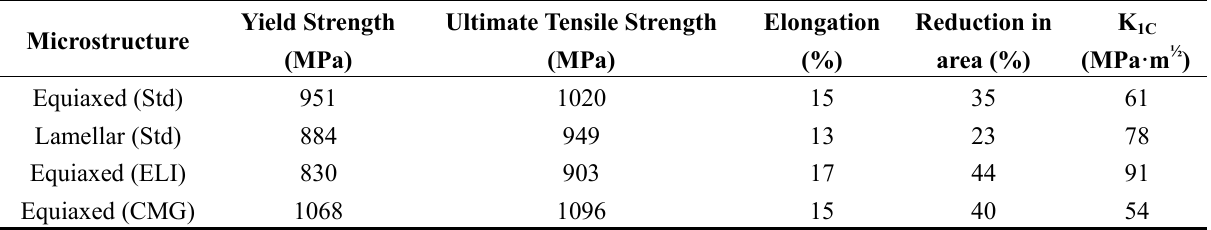
Table 7. Tensile properties of the Ti-6Al-4V alloys [61]. Reprinted with permission from [61]. Copyright 2009